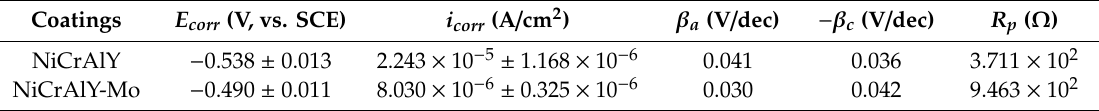
Figure 6. Friction curves ( a ) and wear rate ( b ) of NiCrAlY and NiCrAlY-Mo coatings.